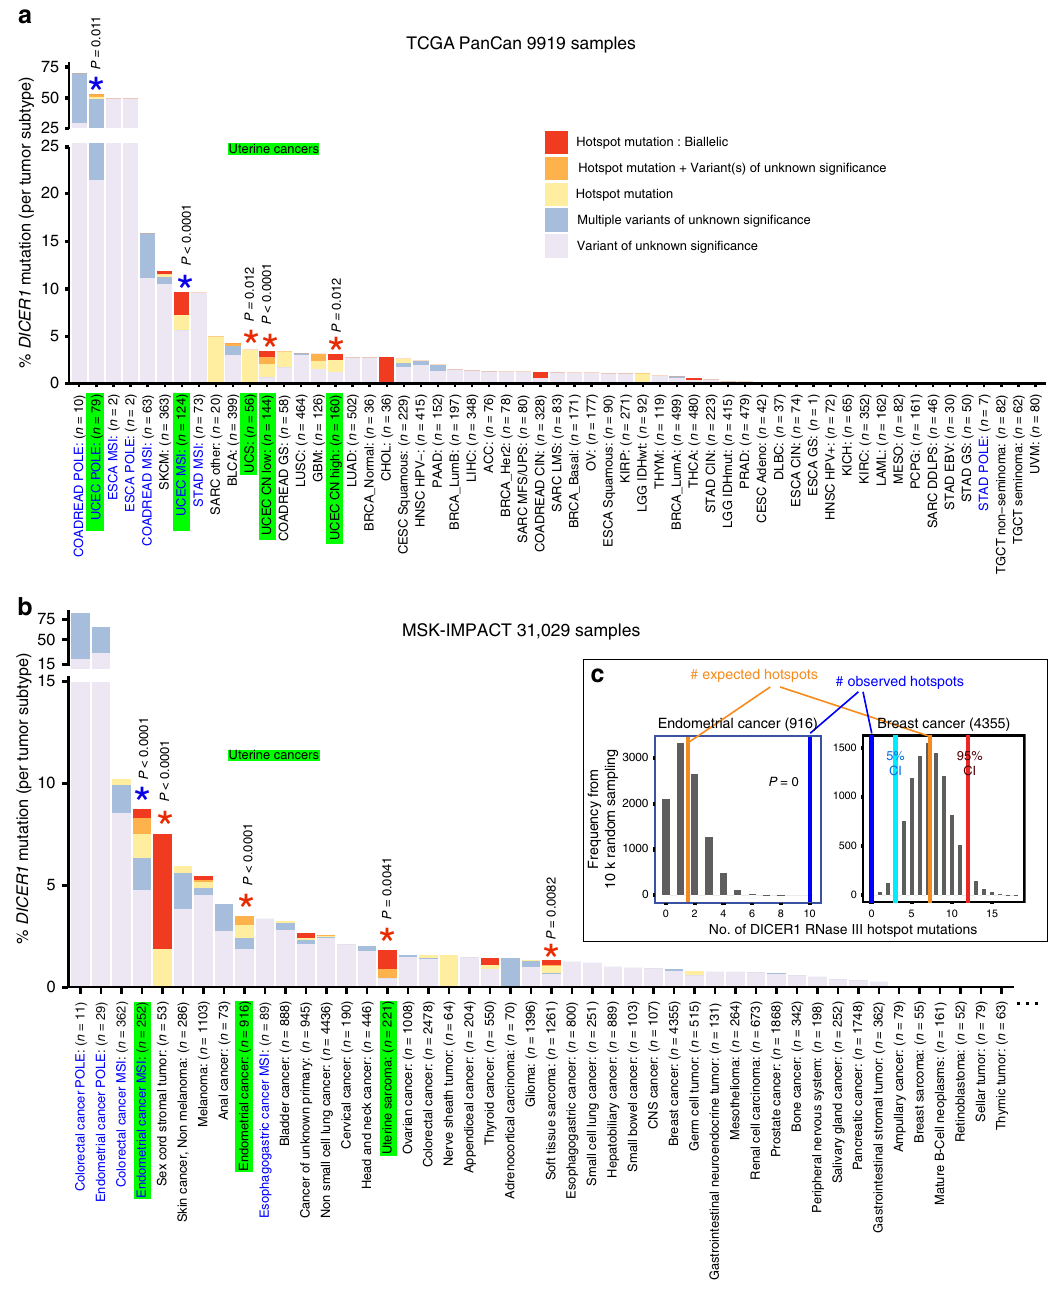
Fig. 2 Frequency of DICER1 mutations in TCGA and MSK-IMPACT data across tumor types. We classify alleles as variants of unknown signi fi cance, RNase IIIa/b hotspot mutations, and/or biallelic mutations in a TCGA-PanCan data and b MSK-IMPACT data. Because of the diversity of MSK-IMPACT cohort, only cancer types with >50 cases are shown, except for certain rare MSI/POLE tumors that are shown to match TCGA hypermutated data. Hypermutated tumors are designated in blue. Note the MSK-IMPACT data is generally underpowered relative to TCGA to call copy number loss; thus, only TCGA data includes biallelic calls for HETLOSS. Many commonly surveyed cancer types ( n for each tumor type summarized below) are devoid of DICER1 hotspot mutations (also see Supplementary Figs. 2 and 3). However, independently in TCGA and MSK-IMPACT datasets, multiple uterine cancers were enriched for hotspot mutations (green highlighted groups on x -axis). Bootstrap resampling analysis with hypermutated cases excluded shows that several uterine cancers and sarcoma subtypes are statistically enriched in both TCGA and MSK-IMPACT datasets (red asterisks). Furthermore, in a second iteration where hypermutated cases were retained in resampling analysis, additional uterine cancers were found enriched for RNase III hotspots (blue asterisks). c Examples of statistical analyses for enrichment or depletion of hotspot mutations in MSK-IMPACT cancer groups. From random samplings of 10,000 bootstrap replicates, the average numbers of hotspot mutations obtained are in blue, while observed numbers of hotspot mutations are in orange. For enrichment, endometrial cancer is shown as an example. Statistical signi fi cance for depletion can only be estimated using percentile con fi dence intervals (CI) when sample sizes are large, as illustrated for breast cancer (zero hotspots, falling well below 5% CI). Statistical analyses for all other cancer groups from TCGA and MSK-IMPACT data are shown in Supplementary Figs. 2 and